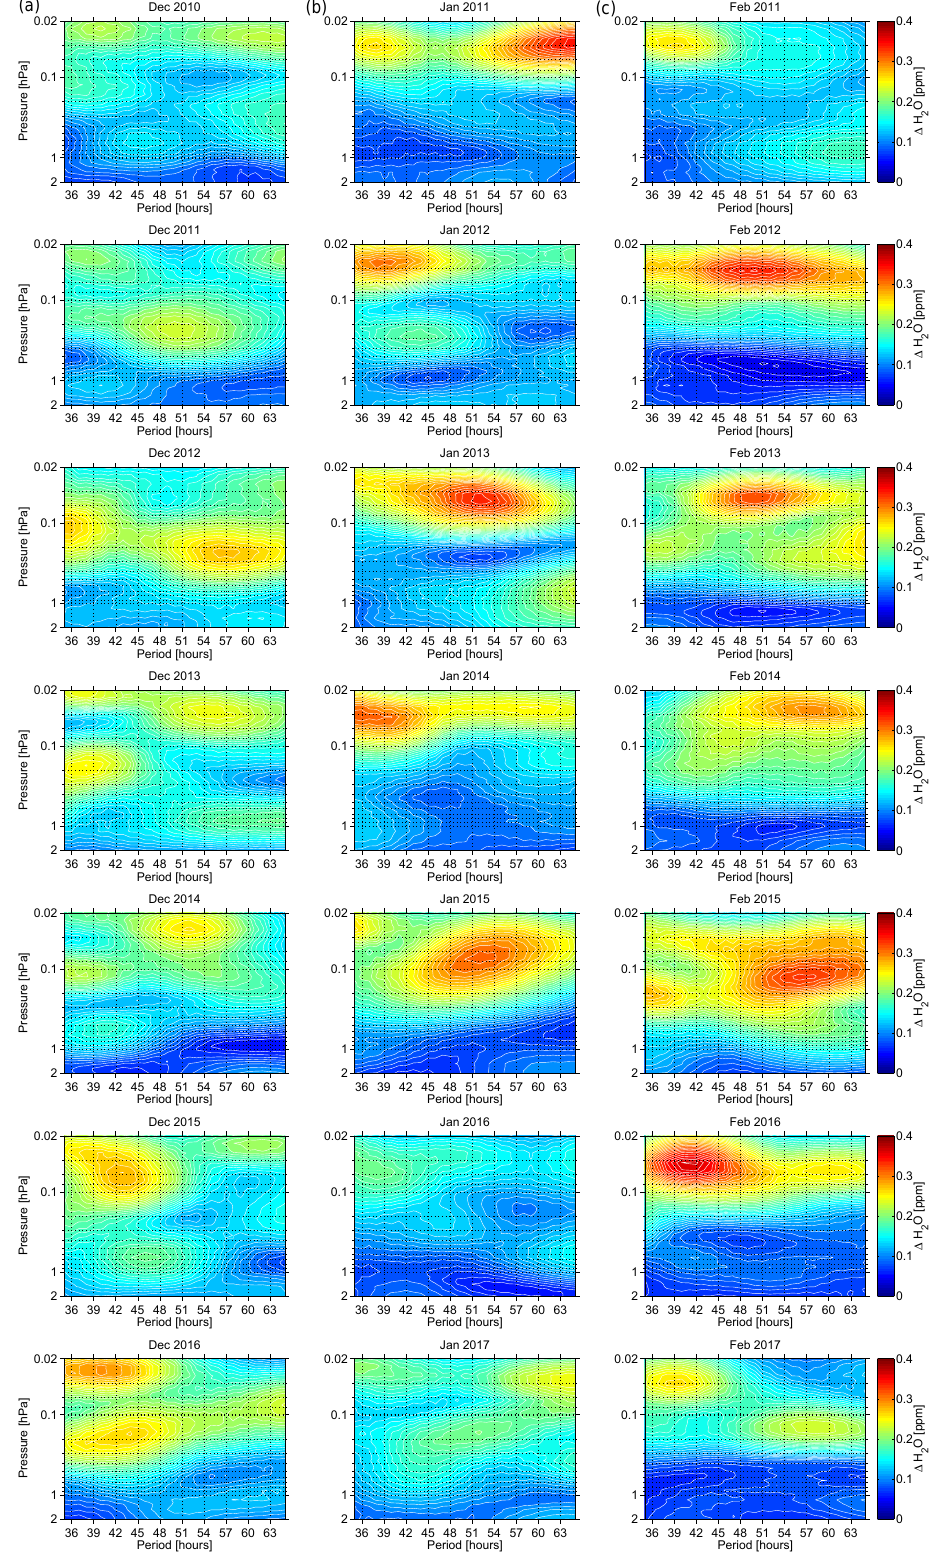
Figure 4. Same representation as in Fig. 4, but for the months December (a) , January (b) and February (c) between 2010 and 2016 and between 2011 and